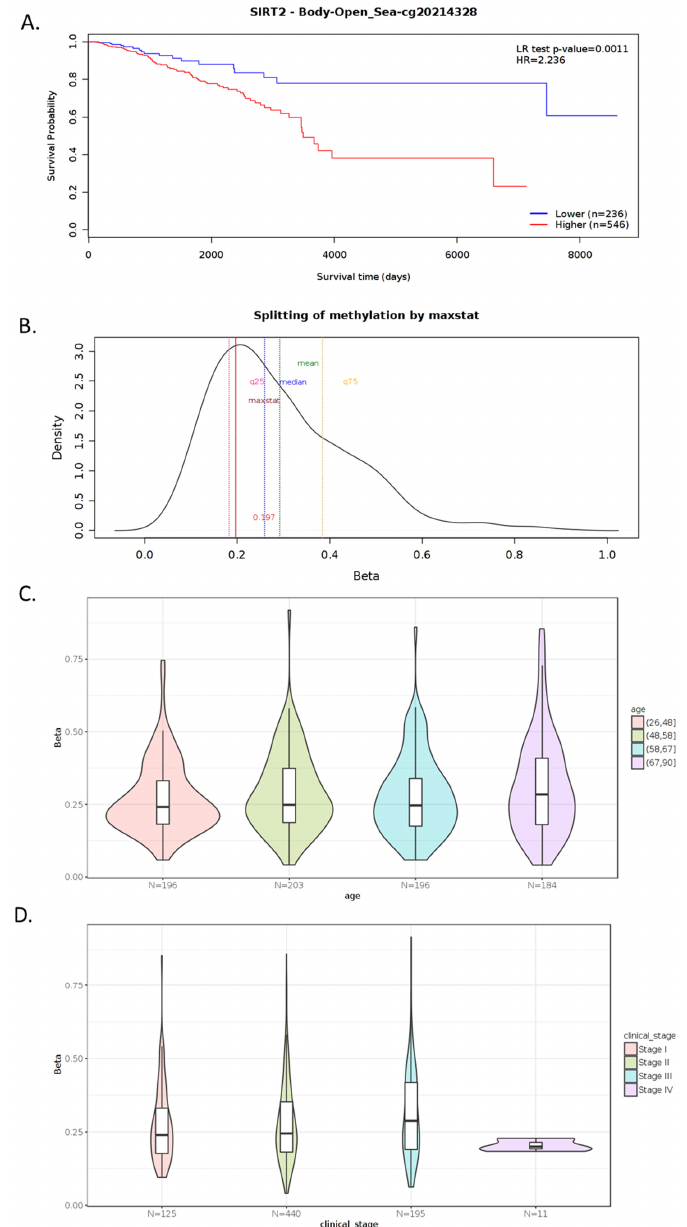
Figure 3. Example of MethSurv graphical outputs generated for CpG cg20214328- SIRT2 in the breast invasive carcinoma samples using a single CpG analysis module. Kaplan–Meier plot showing survival in the higher (shown in red) and lower (shown in blue) methylation groups dichotomized using the maxstat method. The X-axis denotes survival time in days and the Y-axis denotes the probability of patient survival ( A ). Density plot highlighting all the cutoff points evaluated in MethSurv. Different cutoff points are represented by colored texts and the number in red denotes the currently used cutoff point to group the patients ( B ). Violin plots showing the methylation levels among different age groups. Continuous age data are binned into quantiles for visualization ( C ). Violin plots showing the methylation levels among the stage I, II, III and IV BC samples ( D ). A boxplot within each violin plot summarizes the interquartile range and the median methylation levels (shown by a thick black line). The X-axis denotes the patient category while the Y-axis denotes the methylation β -values (ranging from 0 to 1). HR: hazard ratio; LR: log-likelihood ratio; BRCA: breast invasive carcinoma; q25: upper quantile; q75: lower quantile (MethSurv, accessed on 31 March 2022) [57]. More details: https://biit.cs.ut.ee/methsurv/ (accessed on 31 March